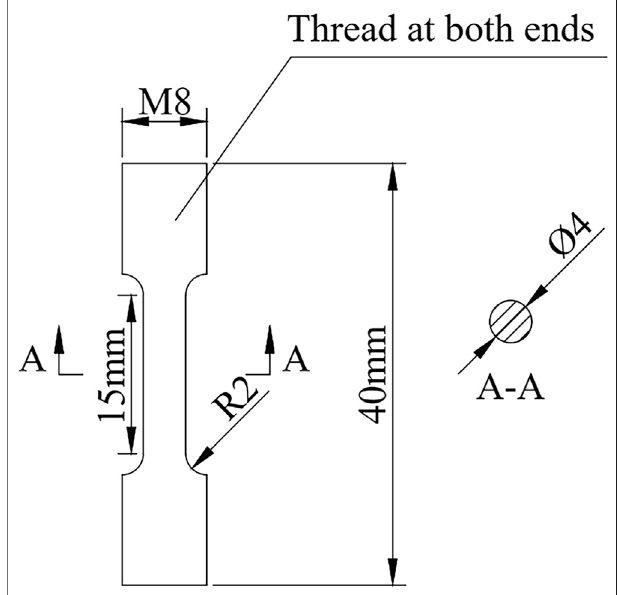
FIGURE 1 | Dimensions of tensile specimens.